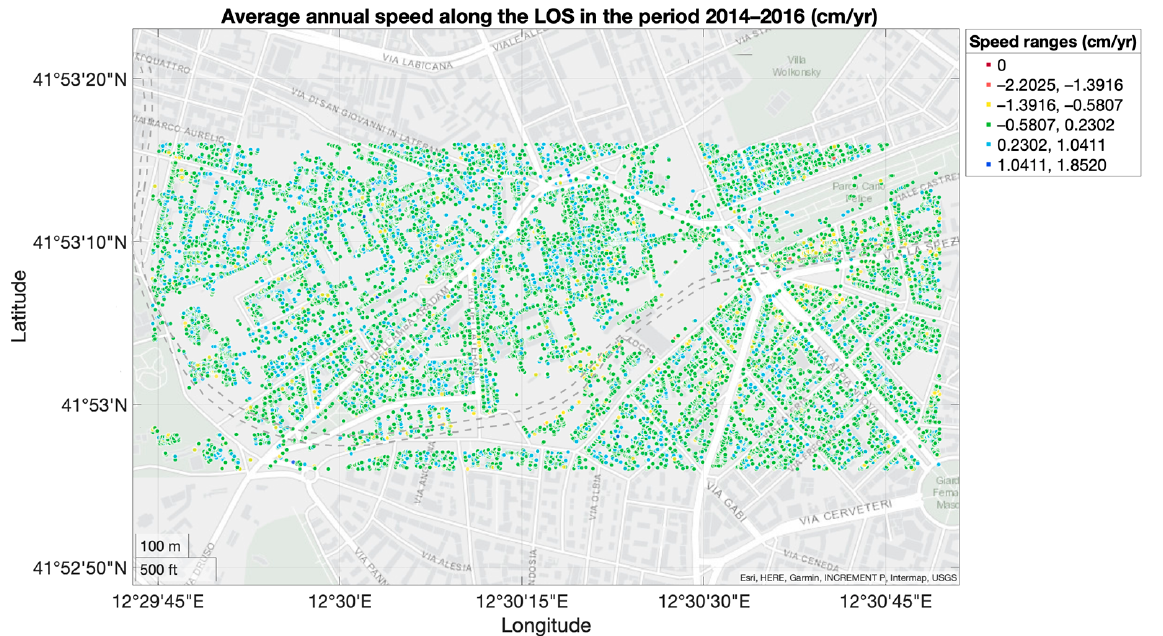
Figure 4. Map showing the dispersion of the average annual velocity along the LOS in the period from 2014 to 2016.